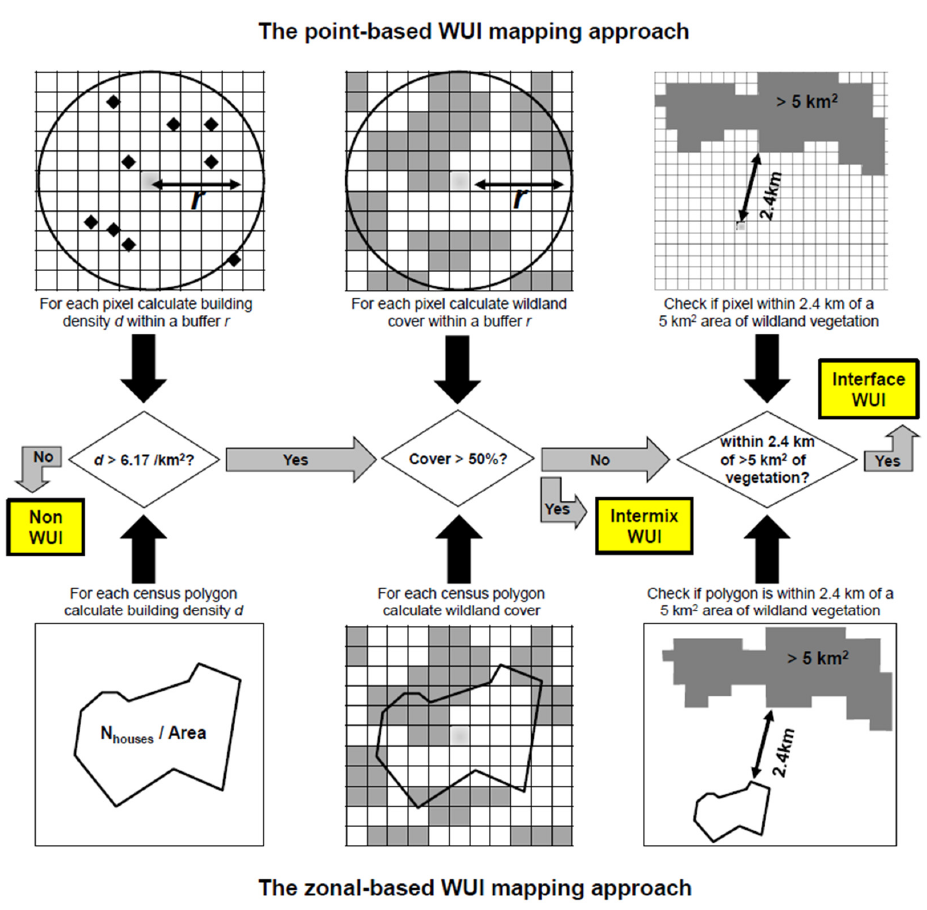
Figure 1. A schematic representation of the two WUI mapping approaches used in this study. Notice the decision processes in the middle are the same for both approaches. The top part of the figure was adapted from [17]. Glossary: intermix WUI is where buildings are interspersed within wildland vegetation; interface WUI is where clusters of buildings adjoin or border patches of wildland vegetation.